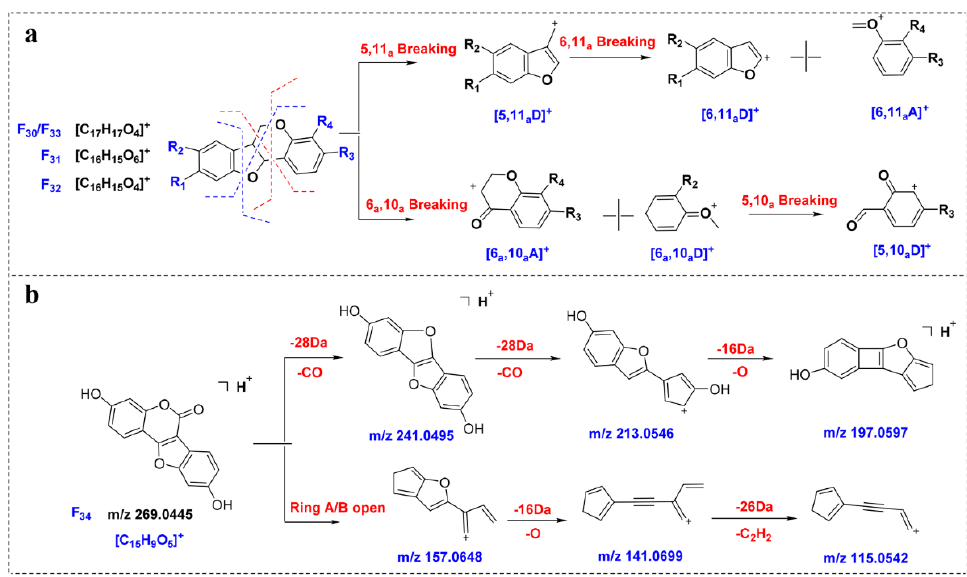
Figure 5. Proposed MS fragmentation pathways of compounds F 30 – F 34 . ( a ) F 30 – F 33 ; ( b ) F 34